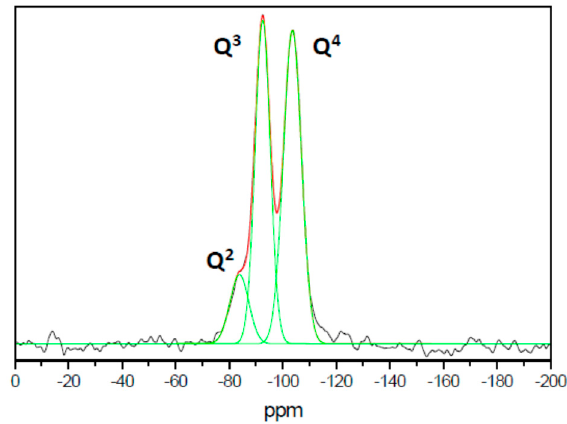
Figure 5. Gaussian deconvolution of the 29 Si MAS NMR spectrum of sample UVM-L12.